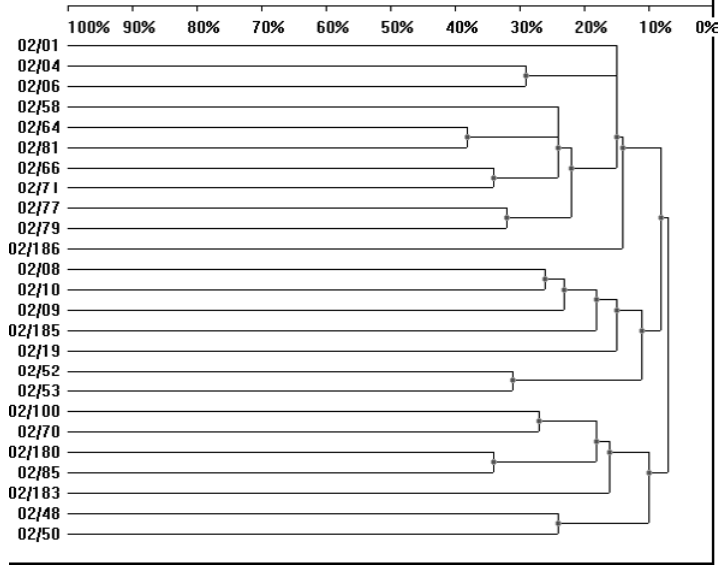
Fig.2. dendrogram of similarity among genotypes of H.